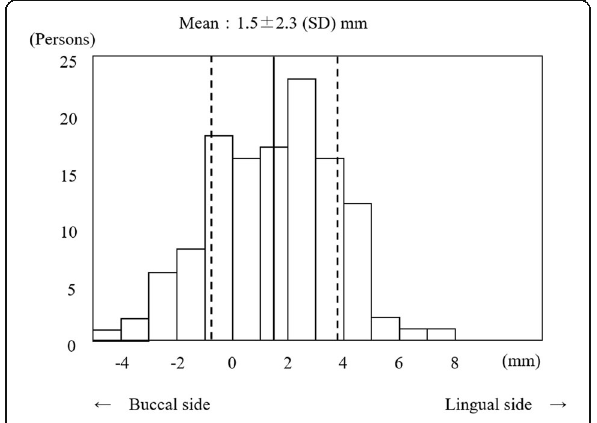
Fig. 10 Distribution of the horizontal distance from the maxillary to mandibular first molars (A – B ’ ) ( n = 27)